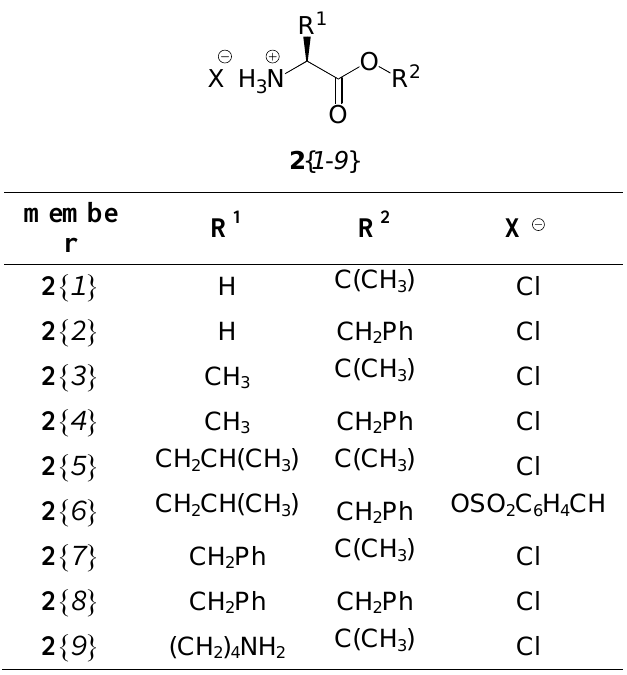
Table 1. Amino acid ester salts, 2 { 1 - 9 }, used in library